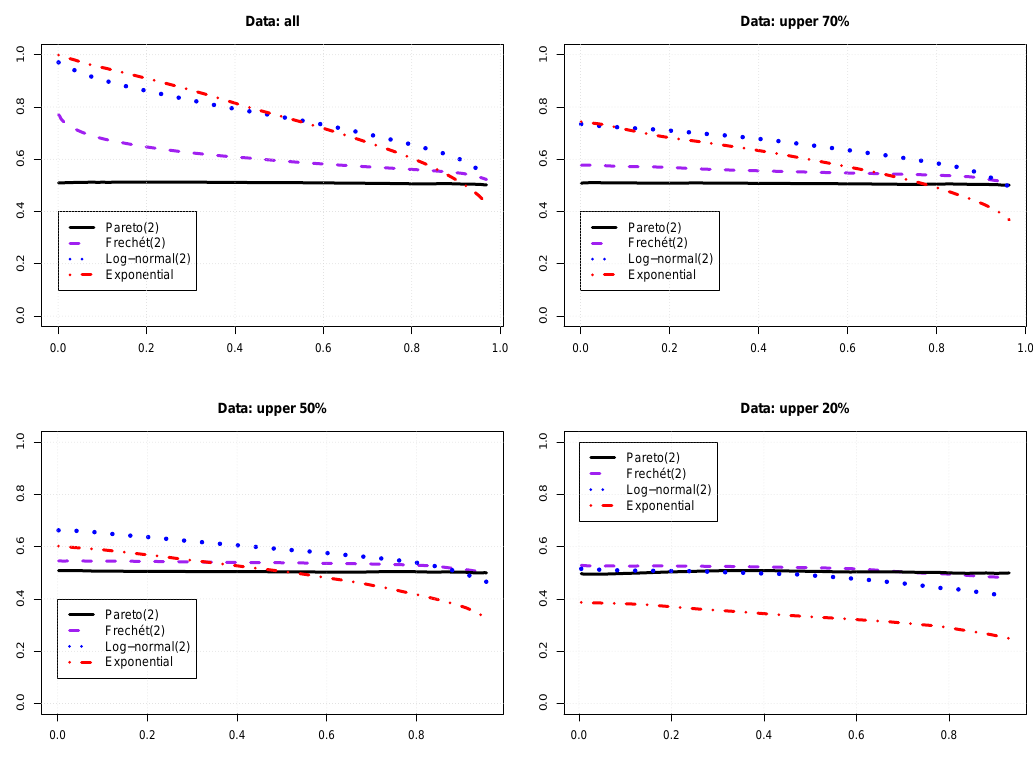
Figure 1. Plot of ˆ λ i ( y -axis) as a function of p i ( x -axis), i = 1, . . . , n , for Pareto, Fréchet, Log-normal and Exponential distributions at various levels of truncation. Sample size n =